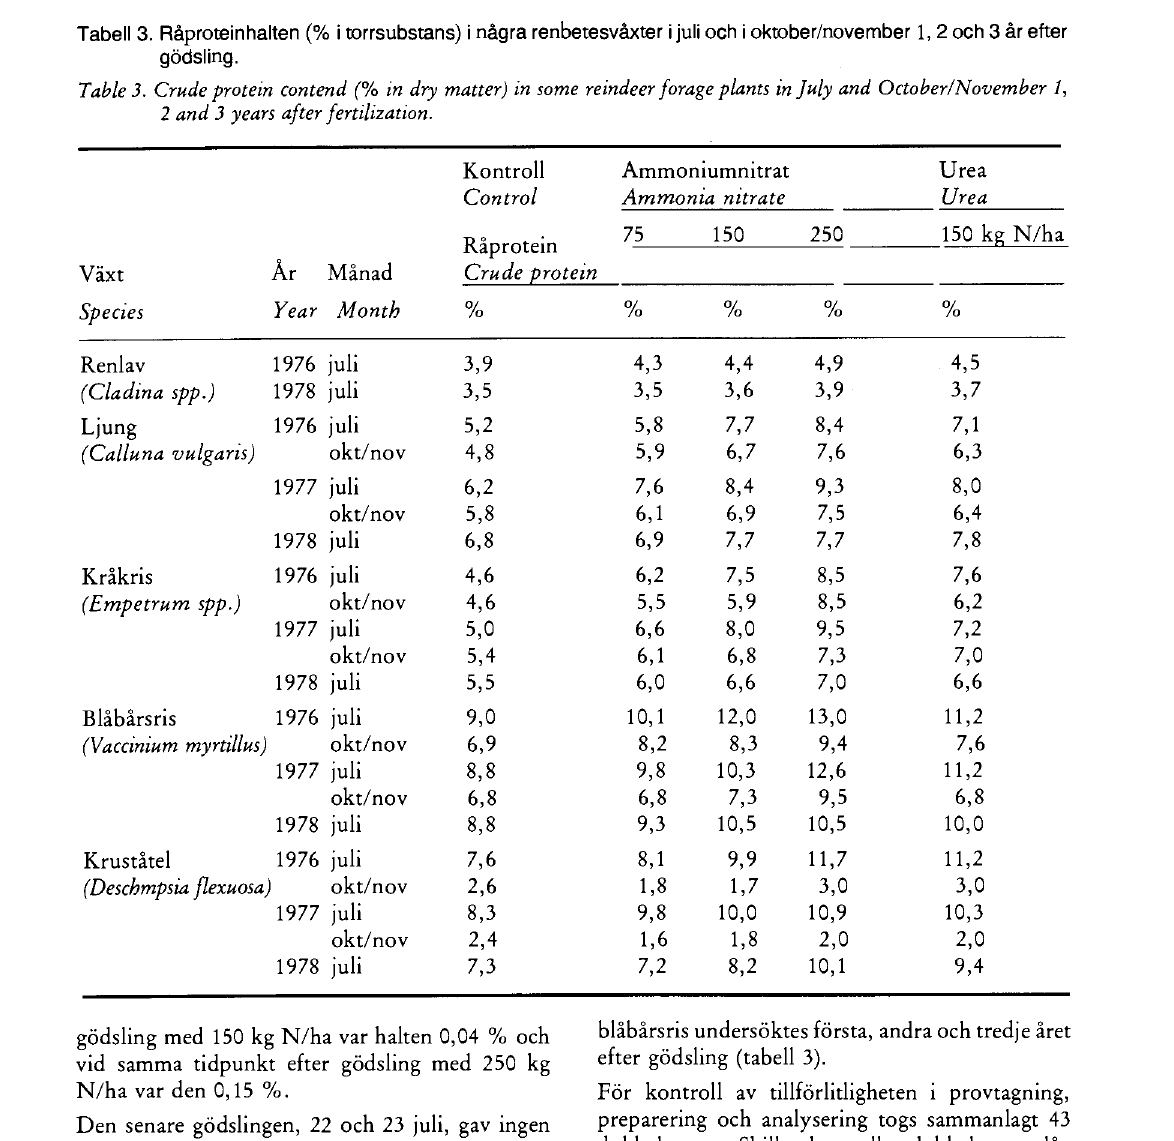
Table 3. Crude protein contend (% in dry matter) in some reindeer forage plants in July and October/November 1, 2 and 3 years after